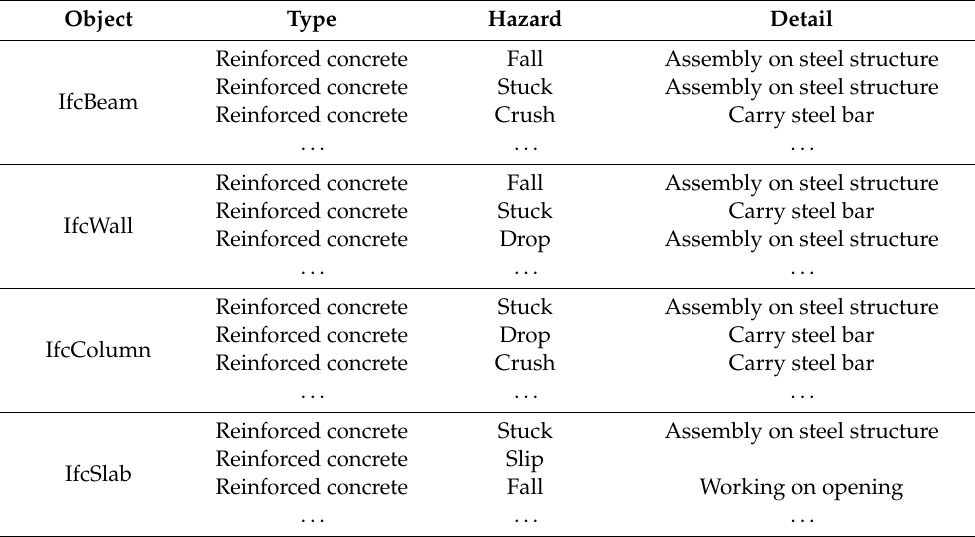
Table 7. Result of derived hazards for each IFC object.